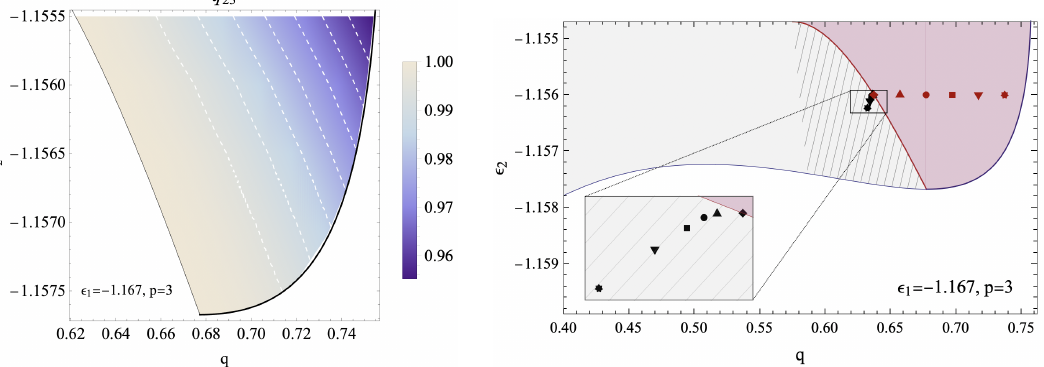
Figure 7: Left. Asymptotic correlation function q , giving the overlap between the 23 minimum s reached asymptotically by the dynamics and the saddle s chosen as 3 2 initial condition. The white dashed lines are level curves. The flatter is the negative direction of the saddle ( i.e. , the closer is ε to ε ), the closer is the minimum reached 2 ms asymptotically. Right. The red points represent the parameters of the saddles chosen as initial conditions for the dynamics, while the black ones are the parameters of the minima reached asymptotically from the saddles with the same symbol. The inset is a zoom of these points. The saddles that have a flatter unstable direction (those at smaller q ) lead to closer local minima. All minima reached asymptotically lie in the region of configuration space that is dominated by minima correlated to the reference one, having one positive isolated eigenvalue (dashed gray